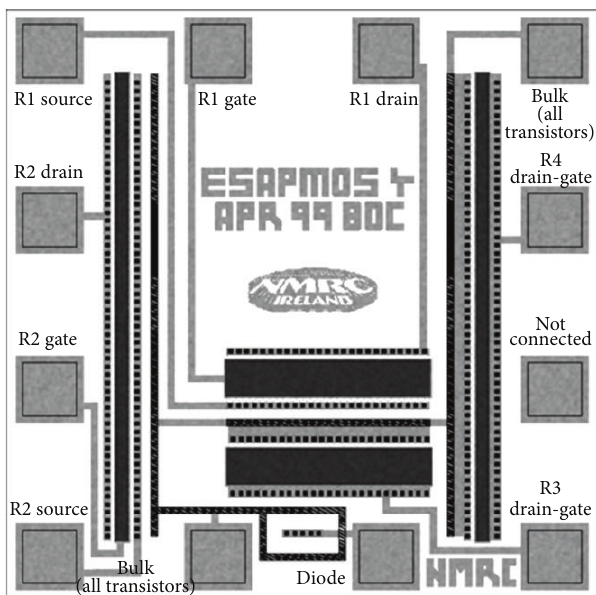
Figure 1: Diagram of a single RADFET used in this study.